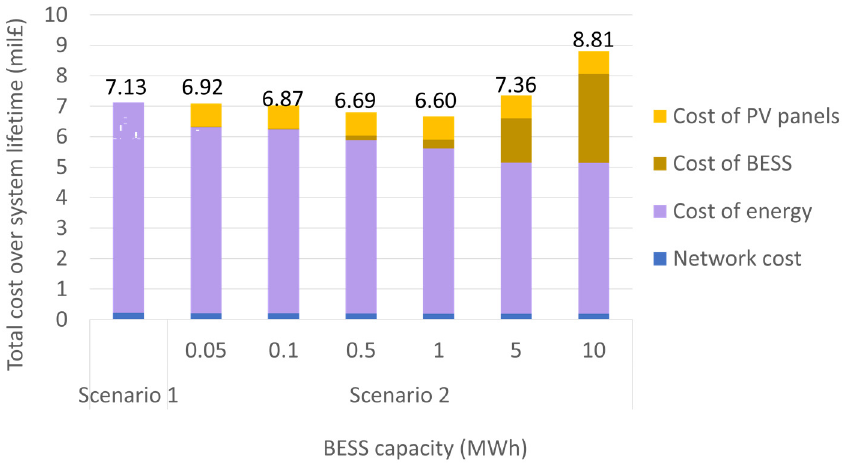
Figure 12. Total cost over system lifetime for scenario 1 and scenario